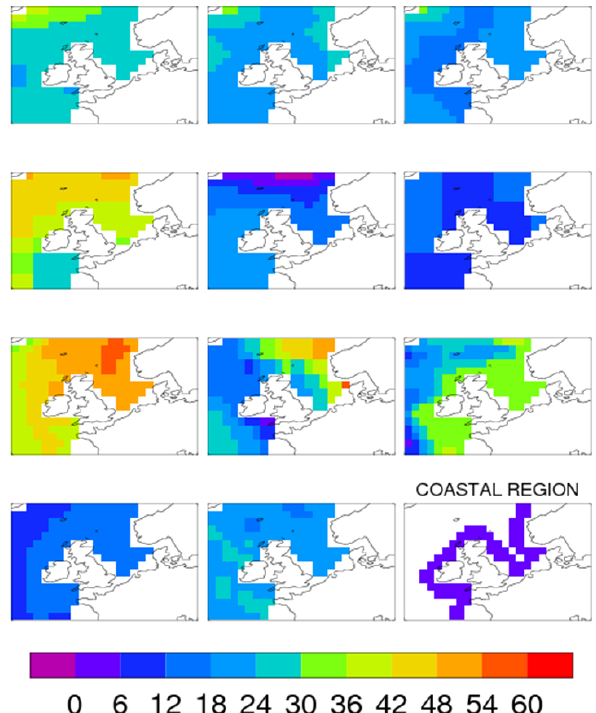
Figure 2. ( TE + ADSL ) in centimetres for the NW European region derived from 11 CMIP3 models. Projections are for the SRES A1B scenario and for the period 2080–2099 relative to 1980–1999. The lower right frame shows the mask used to extract Mn_ADSL